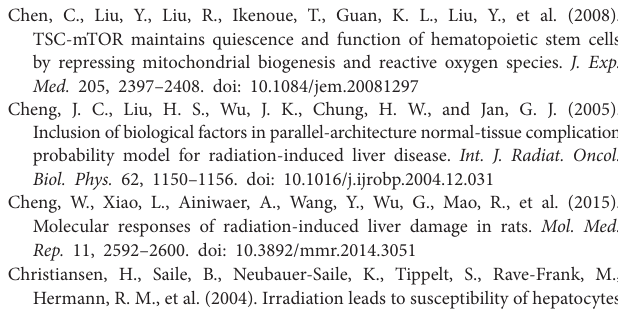
SUPPLEMENTARY FIGURE 1 | Rapamycin treatment decreased numbers of granulocytes in irradiated livers. (A) Gr-1 immunostaining in livers at days 1, 3 and 7 after irradiation (upper panel, n = 6). Numbers of Gr-1+ cells were counted and presented as numbers (No.) of Gr-1+ cells in each field (lower panel, 400× magnification). (B) Gr-1 immunostaining was performed at day 7 after the treatment (upper panel, n = 6). Changes of numbers of Gr-1+ cells in each field were presented after irradiation and/or rapamycin treatment (lower panel, 400× magnification). ***p < 0.001 vs non-irradiated control (CTL). #p < 0.01 vs. irradiated mice with rapamycin